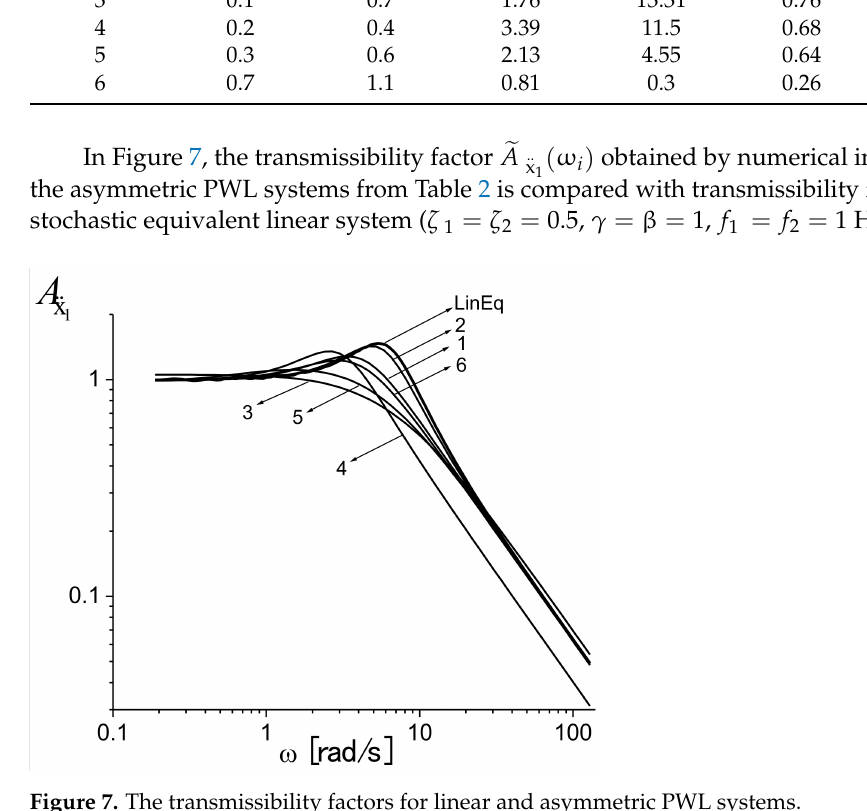
Figure 7. The transmissibility factors for linear and asymmetric PWL